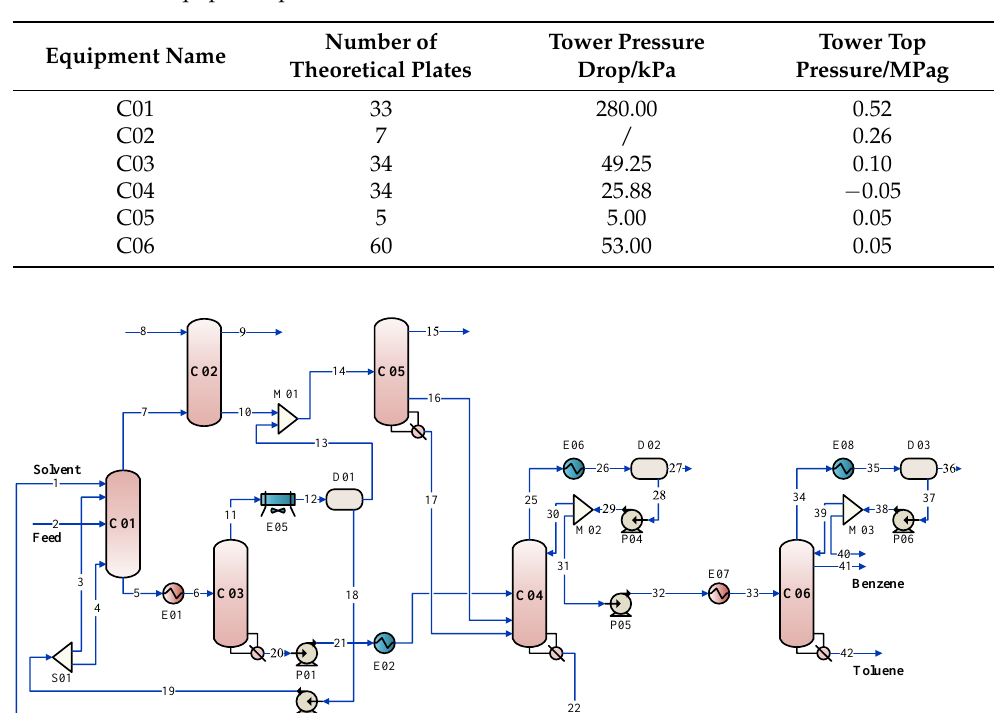
Table 4. Tower equipment parameters.